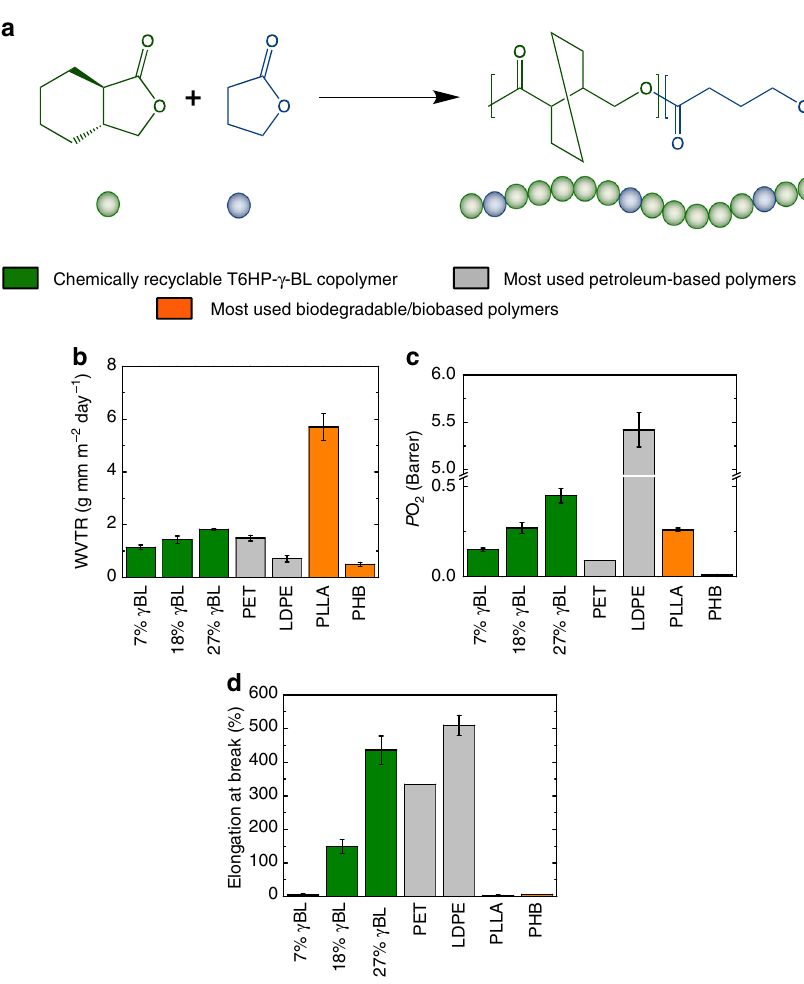
Fig. 2 Synthesis of copolymers and their properties. a Schematic representation of copolymerization of T6HP and γ BL. b Water vapor transmission rate of chemically recyclable copolymers and commercially available PET, LDPE and biobased/biodegradable PLLA and PHB. c Oxygen permeability coef fi cient of PT6HP, P γ BL, PET, LDPE, PLLA, and PHB. d Elongation at break of PT6HP, P γ BL, PET, LDPE, PLLA, and PHB. Error bars correspond to the standard deviation (s.d.) of at least four